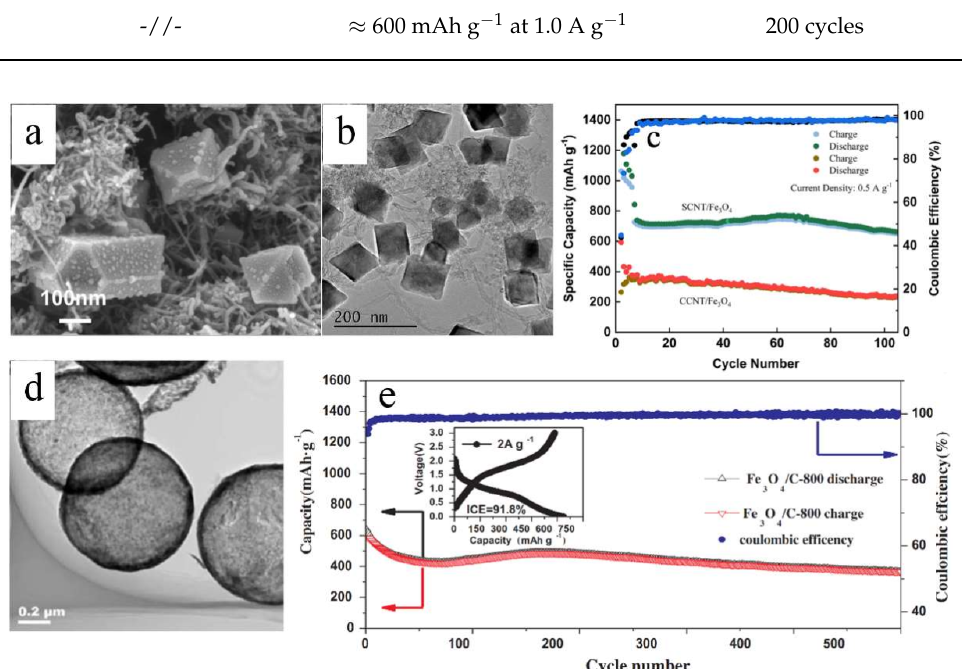
Figure 6. ( a ) Scanning electron microscopy (SEM) image and ( b ) low magnification transmission electron microscopy (TEM) of SCNT/Fe 3 O 4 [35]. ( c ) Specific capacity and Coulombic efficiency of SCNT/Fe 3 O 4 and CCNT/Fe 3 O 4 at 0.5 A g − 1 as a function of cycle number [54]. ( d ) TEM image